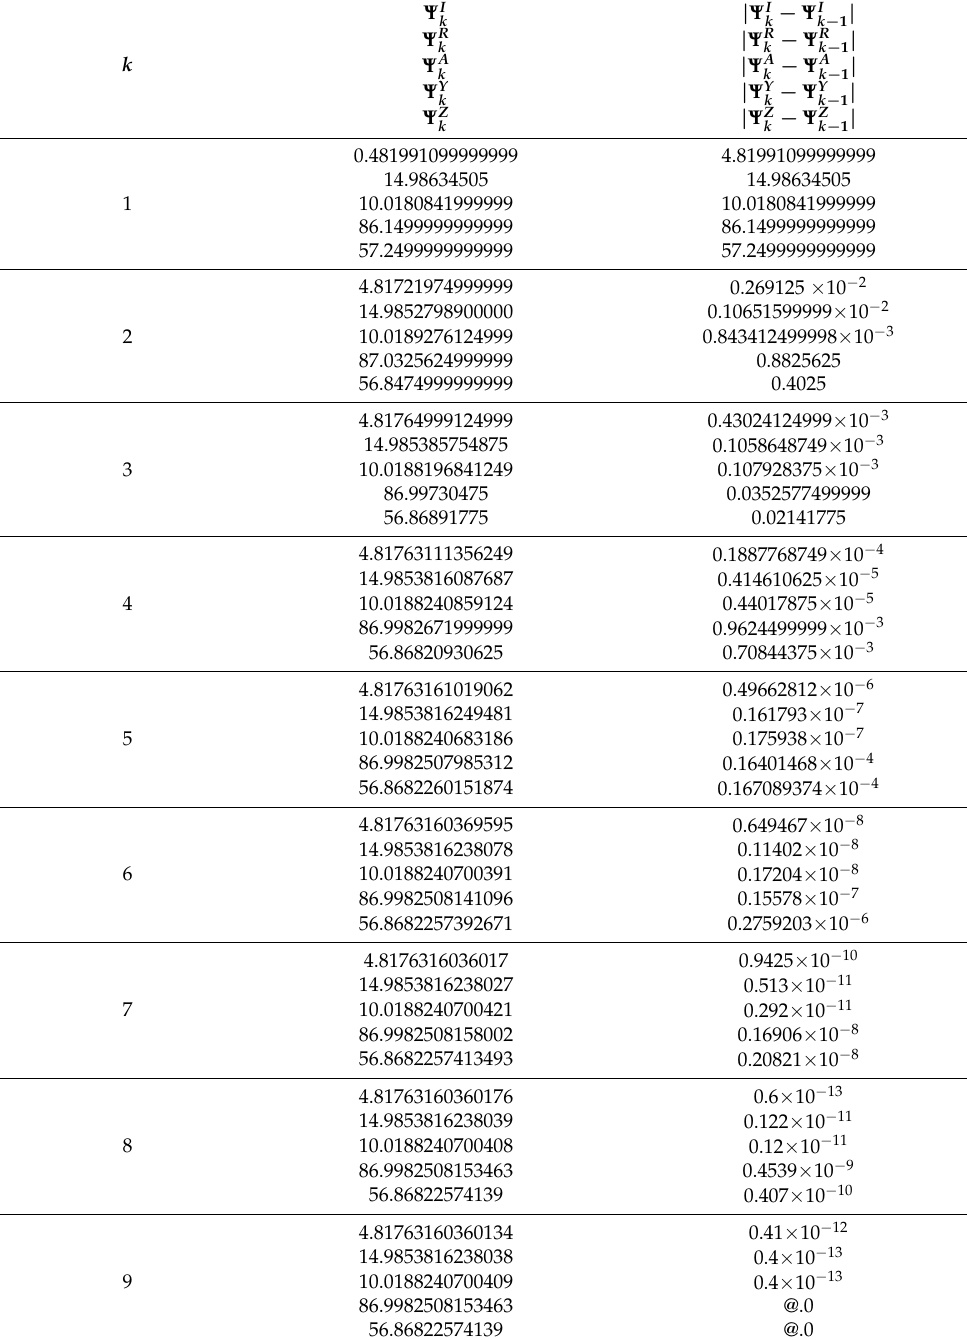
Table 4. The numerical results using the CESTAC method for t = 0.5, ρ = 1 and ¯ h = −